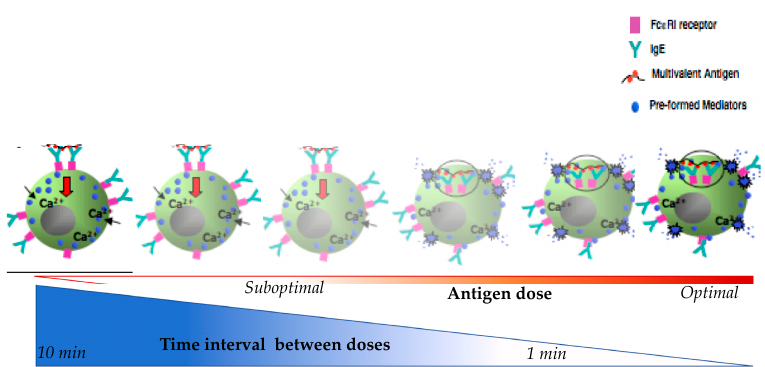
Figure 2. Schematic diagram represent of mast cells β -hexosaminidase in relation to time interval between doses and antigen doses during desensitization.